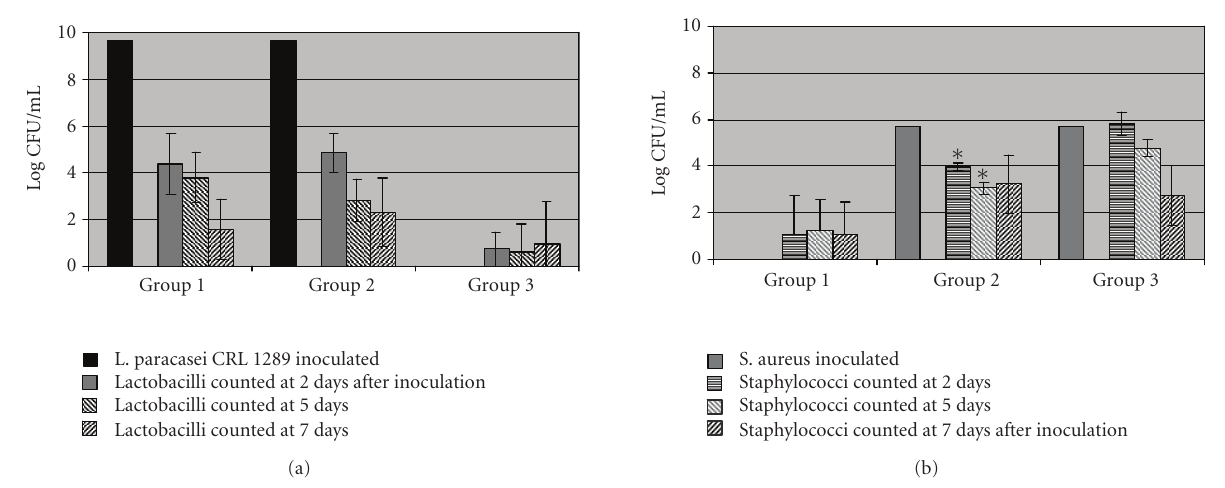
Figure 2: Viable counts of lactobacilli (panel A) and staphylococci (panel B) on the vagina of mice inoculated only with these microorgan- isms or pretreated with L. paracasei CRL 1289 and challenged with uropathogenic S. aureus . Panel A: ( (cid:2) ) L. paracasei CRL 1289 inoculated, ( ) lactobacilli counted at 2 days after inoculation; ( ) lactobacilli counted at 5 days; ( ) lactobacilli counted at 7 days. Panel B: ( ) S. aureus inoculated; ( ) staphylococci counted at 2 days; ( ) staphylococci counted at 5 days; ( ) staphylococci counted at 7 days after